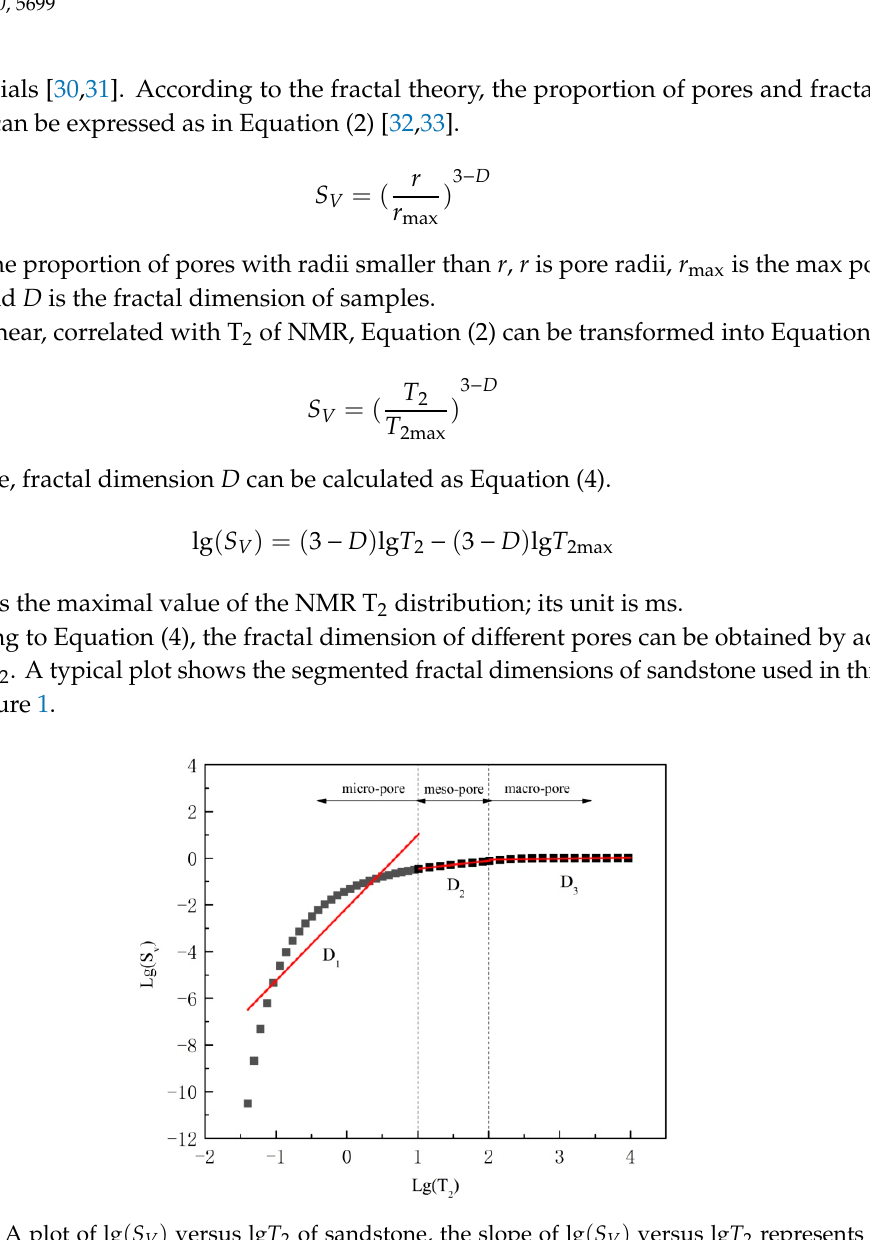
Figure 1. A plot of lg ( S V ) versus lg T 2 of sandstone, the slope of lg ( S V ) versus lg T 2 represents the value of 3-D; D 1 represents fractal dimension of micro pores, D 2 represents fractal dimension of meso pores and D 3 represents fractal dimension of macro pores.